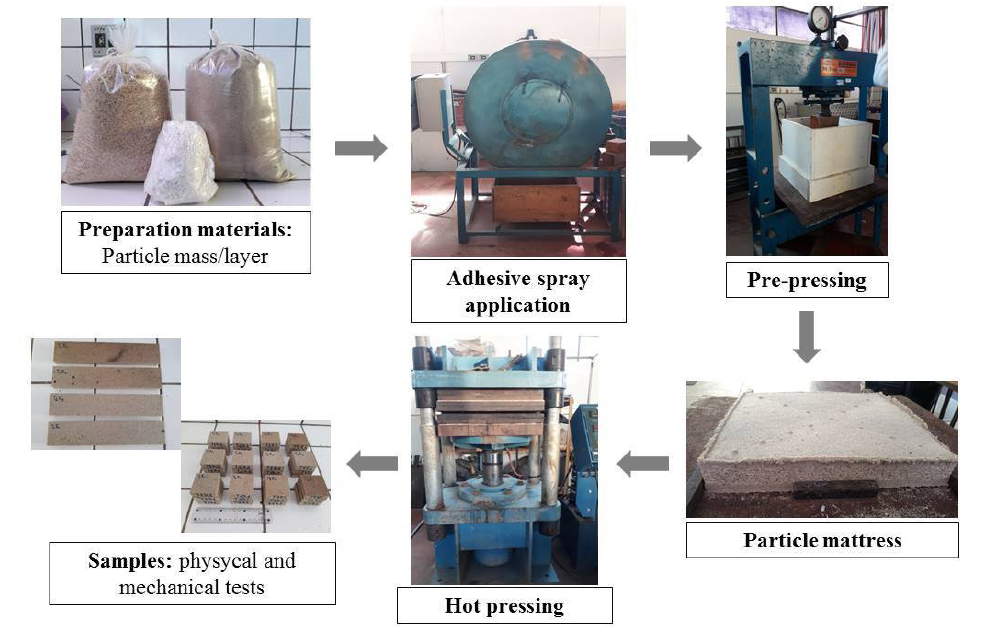
Figure 1. Production sequence of the particleboard.